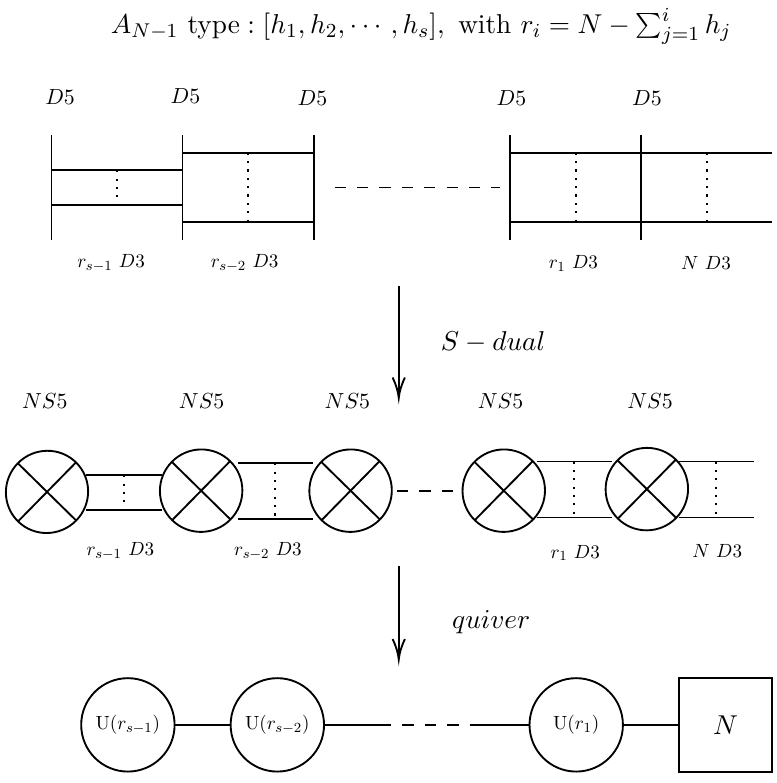
Figure 7 . Upper row: We construct a D 5 − D 3 brane system for a A type partition. Middle row: We perform S duality on the brane system in upper row, which turns a D5 brane to a NS5 brane, and a D3 brane to a D3 brane. Bottom row: We read a quiver gauge theory from the middle row. The rule is following, we associate a U( r ) gauge group for r D3 branes suspending between NS5 brane, and each NS5 brane contributes a hypermultiplet in bi-fundamental